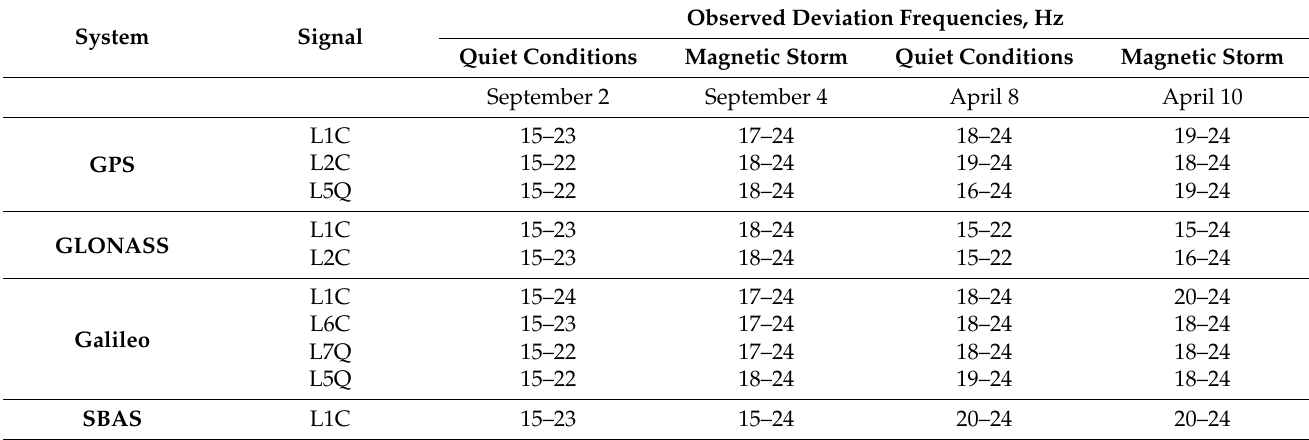
Table 2. The deviation frequencies obtained from Septentrio receiver at 50 Hz sampling rate.